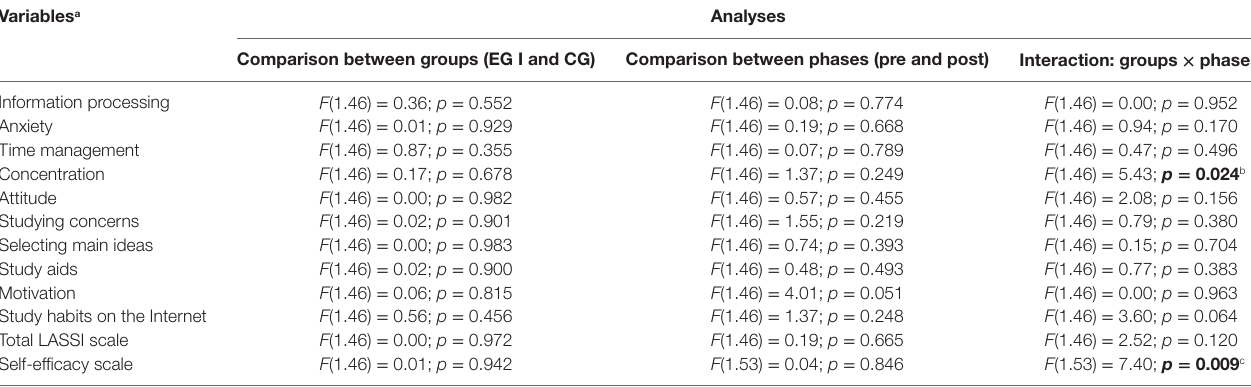
TaBle 3 | ANOVA results for comparison between the Experimental Group (EG) I—Class A and control group (CG)—Class D scores. Variables a analyses comparison between groups (eg i and cg) comparison between phases (pre and post) interaction: groups × phases Information processing